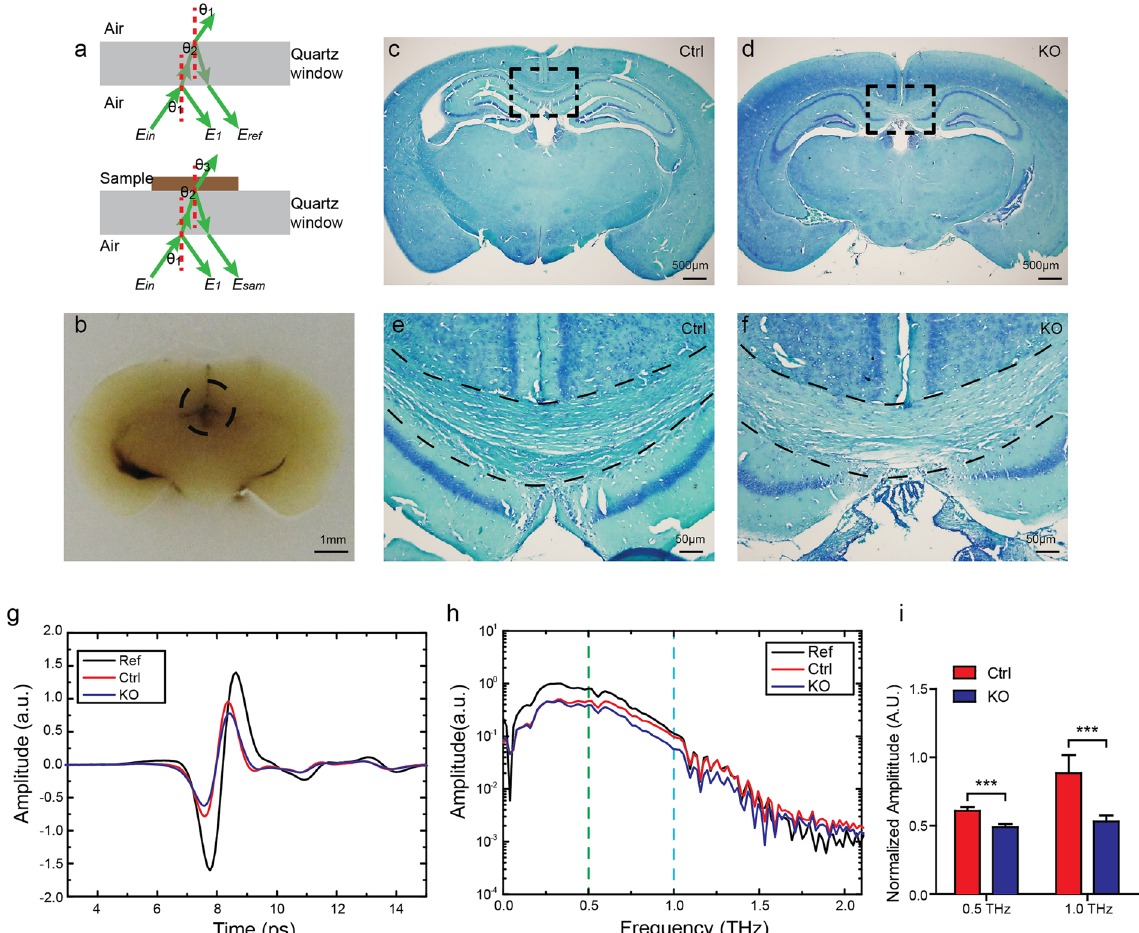
Figure 1. Reflected THz spectra of myelin deficit brain from Rheb1 KO mice. ( a ) Schematic diagram of the reflective THz-TDS measurement. ( b ) White-field images of paraffin-embedded brain coronal sections from a mutant mouse. ( c – f ) Luxol-Fast Blue (LFB) staining shows myelin deficit in corpus callosum (regions in dash line) of Rheb1 KO brain. ( g ) THz time-domain waveforms reflected by Rheb1 KO brain samples (blue), normal brain samples (red) and the substrate without sample (black). ( h ) Fourier-transformed spectrum of the THz time-domain waveforms in ( g ). ( i ) Quantification of normalized amplitudes at 0.5 and 1.0 THz. Data represent mean ± SD, n = 3, *** p <